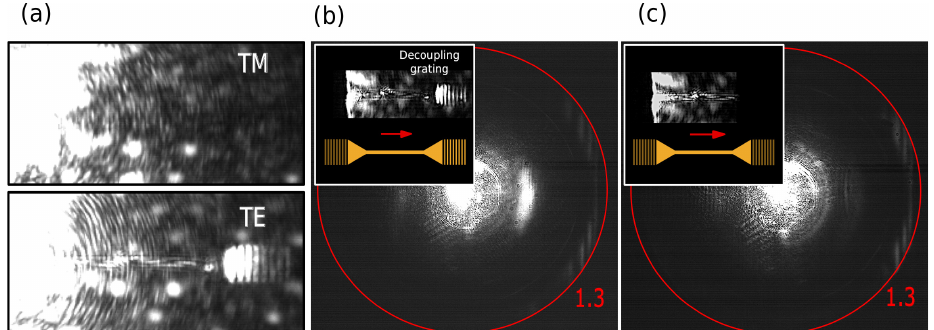
Figure 4. ( a ) Direct plane image of the fabricated device for transverse electric- (TE-) and transverse magnetic- (TM-) polarisations of incident light. A grating-shaped spot on the right corresponds to the radiation, which was coupled to waveguide modes and subsequently radiated into the far field by decoupling grating; ( b , c ) back focal plane (BFP) and direct plane images of sample 4 with open ( b ) and closed ( c ) decoupling grating. Red circle defines numerical aperture (NA) = 1.3 of collecting